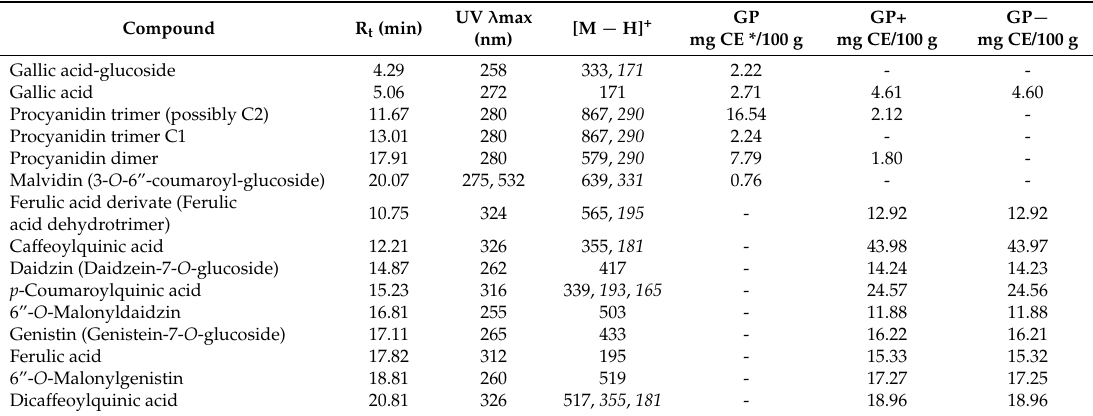
Table 3. Phenolic profile and the phenolic compounds concentration (mg CE*/100 g) in GP, GP+ feed and GP − feed samples (LC-MS